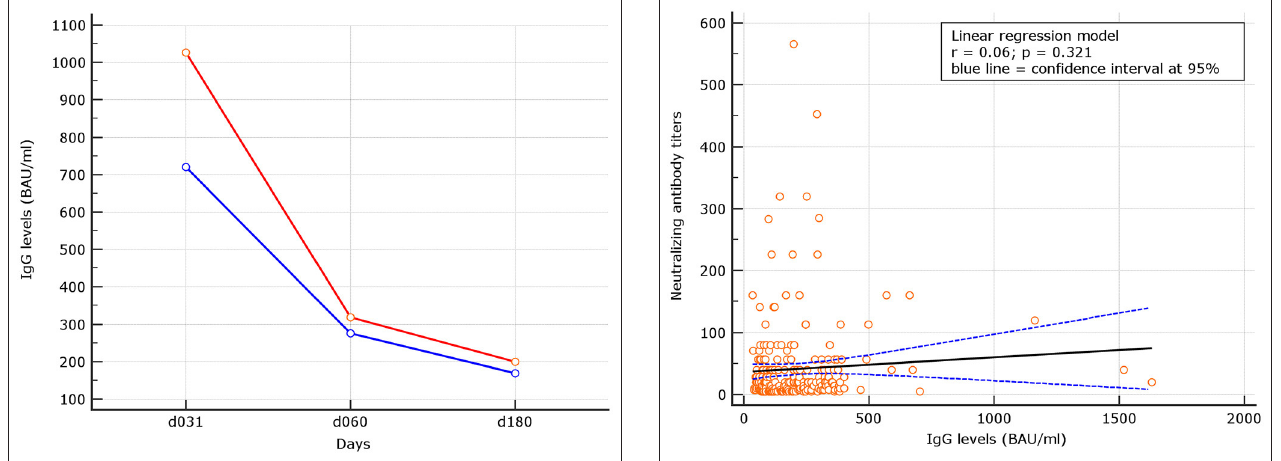
FIGURE 2 | Trend analysis of IgG levels at the different time points. In red median of IgG levels in subjects with median age ≤ 47 years. In blue median of IgG levels in subjects older than 47 years, linear trend was statistically significant for both ( p < 0.0001).